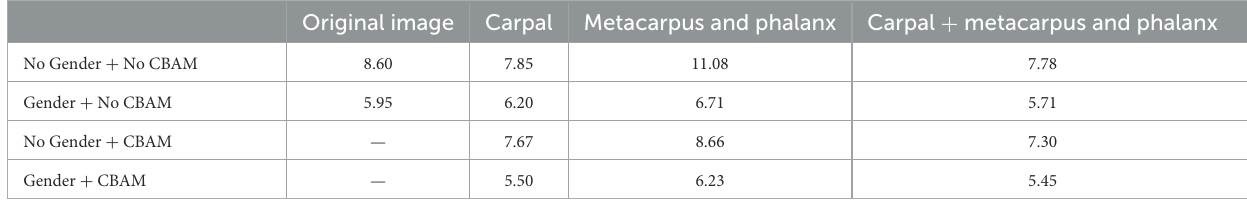
TABLE 2 Effect of attentional mechanism and gender information on prediction